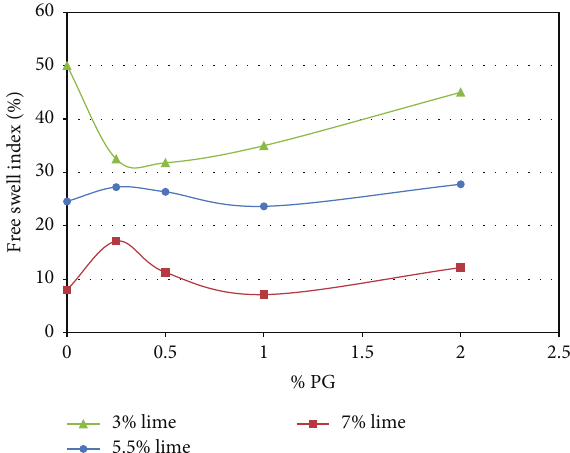
Figure 8: Free swell of lime stabilized soil admixed with